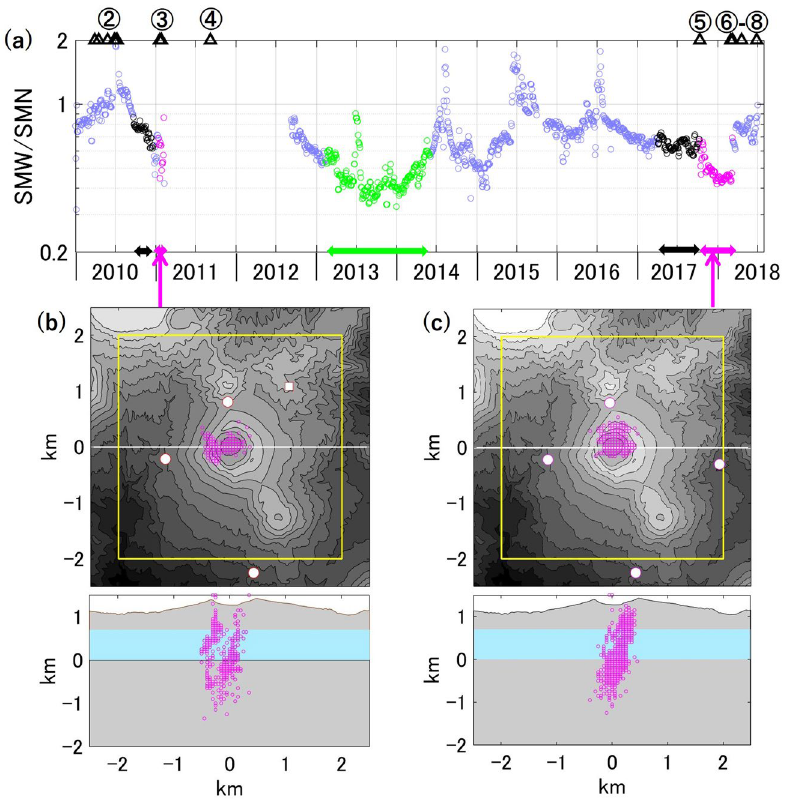
Figure 5. ( a ) The ratio of weekly smoothed SBLs at SMW to SMN. Note that the vertical axis is logarithmic. Black indicates precursory periods (September 20–December 20, 2010 and April 1 –October 10, 2017), green indicates the non-eruptive SBL increase in 2013–2014 (February 10, 2013–June 1, 2014), and pink indicates volcanic tremor periods analyzed by Ichihara and Matsumoto 47 (January 13–February 7, 2011) and in this study (October 10, 2017–March 9, 2018). The black triangles and circled numbers are the same as in Fig. 2. ( b , c ) The tremor sources are presented for the 2011 eruption in ( b ) 47 and for the 2017–2018 eruption in ( c ). The upper panel shows the topographic map centered at the Shnmoe-dake crater. The yellow frame encloses the area we searched for the sources (see Ichihara and Matsumoto 47 ). The cross section along the white line is displayed in the bottom panel. The vertical axis is the elevation above sea level, and light-blue area indicates the water-table depth 56